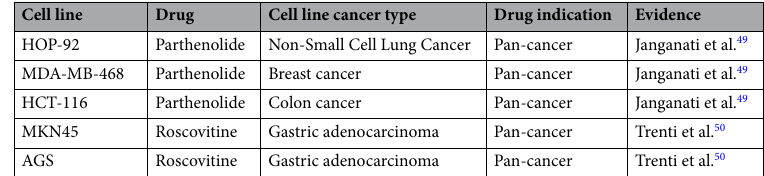
Table 8. The Literature evidence for some of sensitive predictions of ADRML about novel cell line-drug pairs. These cell line-drug pairs has unknown IC50 in the training dataset and ADRML predicted them as the sensitive prediction. The evidence papers for these predictions are represented in the last